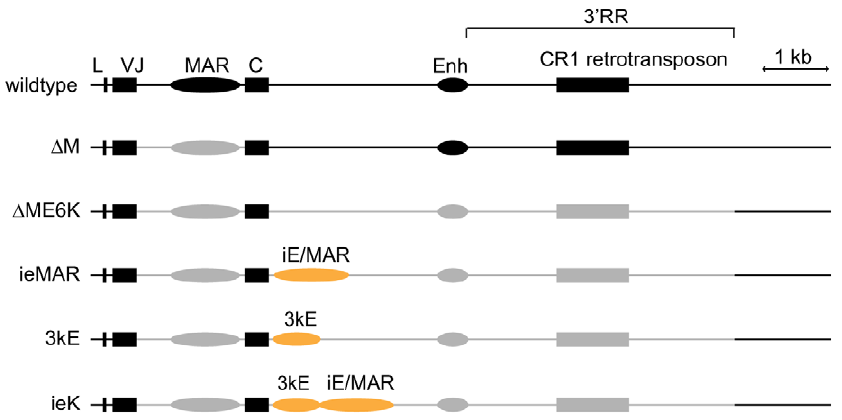
Figure 1. Schematic representation of the IGL loci in individual DT40 lines. The rearranged allele of the IGL locus in the indicated cell lines is drawn to scale. The leader (L), the VJ exon, constant region (C), and the CR1 retrotransposon (present in the published chicken genome as well as in DT40 cells, S.D.F. unpublished) are shown as filled boxes. The putative matrix attachment region (MAR) and the 467 bp enhancer (Enh) are shown as filled ovals. Elements that are present are shown in black, those that are deleted are in grey. The murine enhancer elements (iE/MAR and 3kE) in the respective knock-in alleles are depicted as orange ovals.